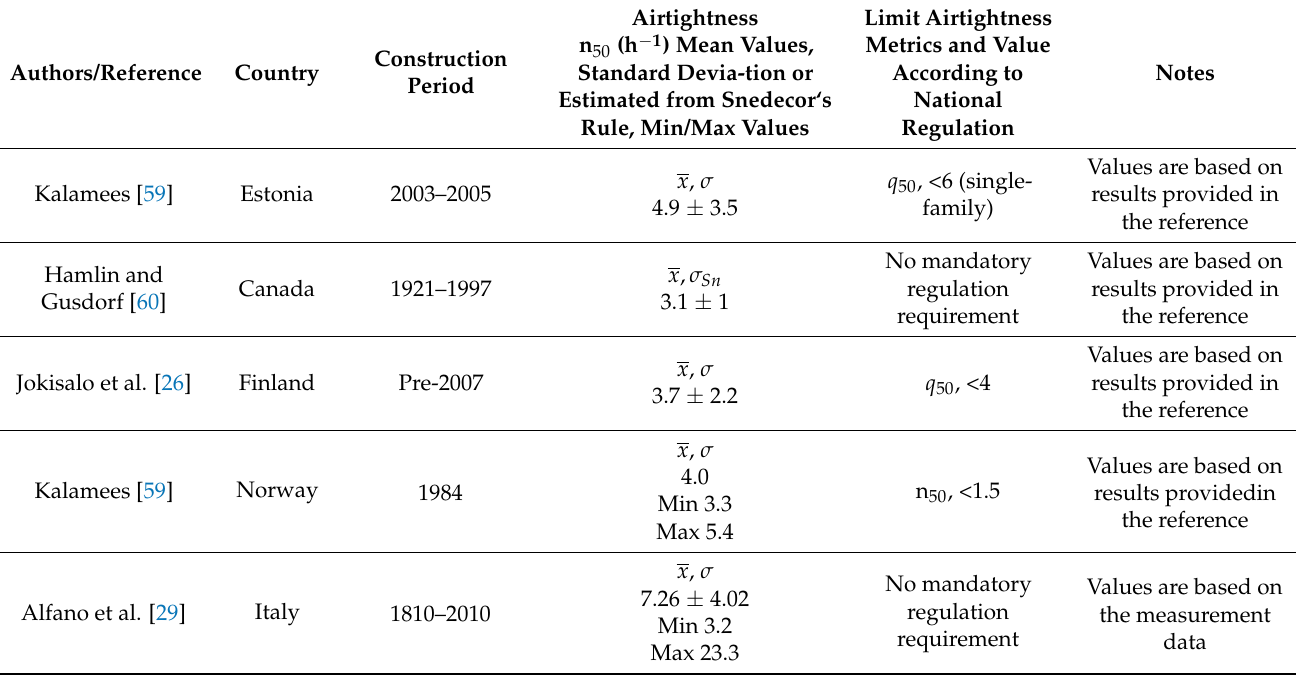
Table 3. Comparison of statistical airtightness measurement data between previous studies and the current research.